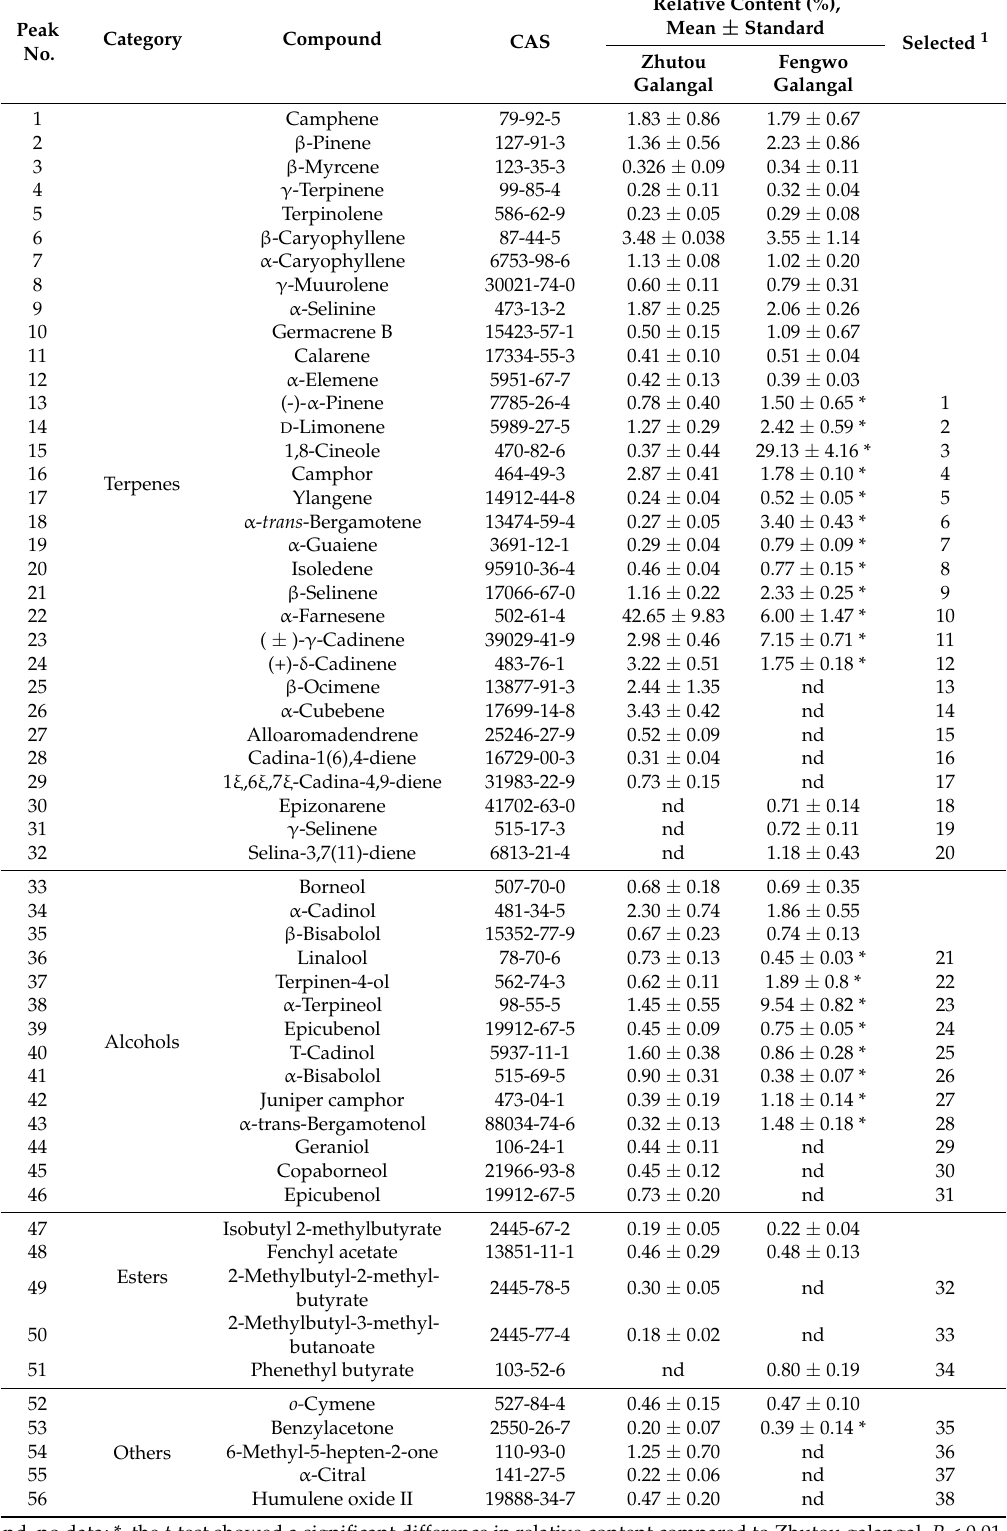
Table 3. Identified volatile compounds of Zhutou galangal and Fengwo galangal by GC-MS. Peak